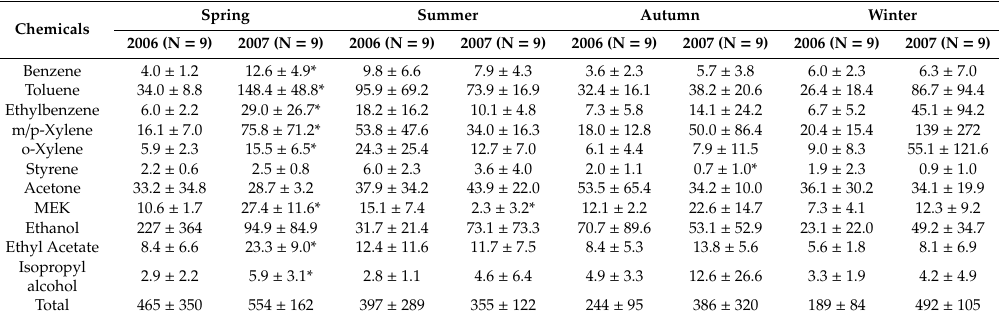
Table 2. Seasonal variations of indoor VOC concentrations ( µ g / m 3 ) in 2006 and 2007.